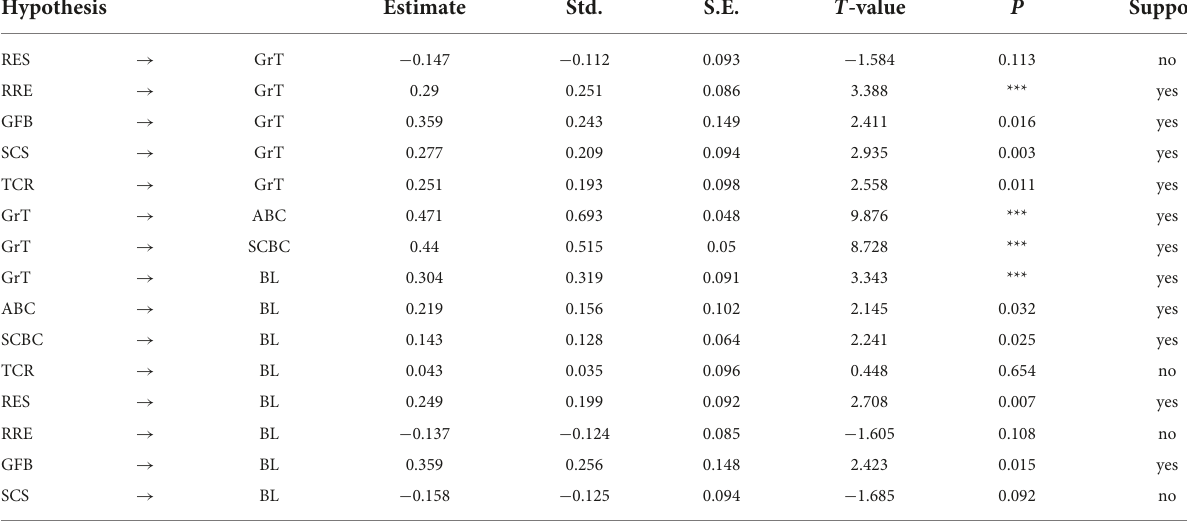
TABLE 5 The result of structural equal model